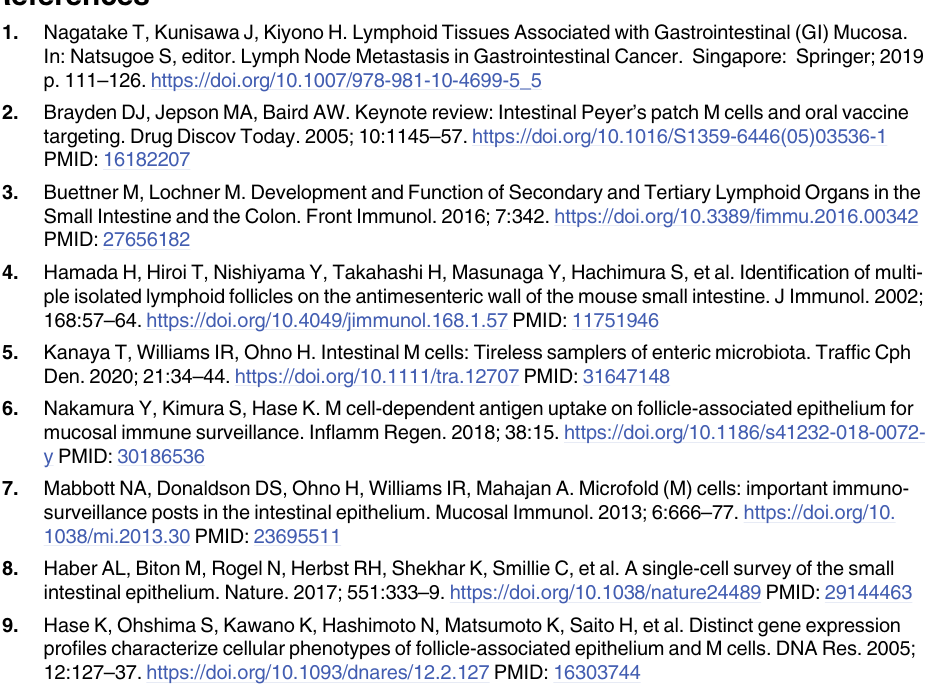
S5 Data. Raw data of smFISH validations. Thirteen smFISH single-cell measurements, one gene per tab. (XLSX) S6 Data. Gene markers. Lists of gene markers of Ribosomes, solute carriers, M cells, B cells, and T cells.